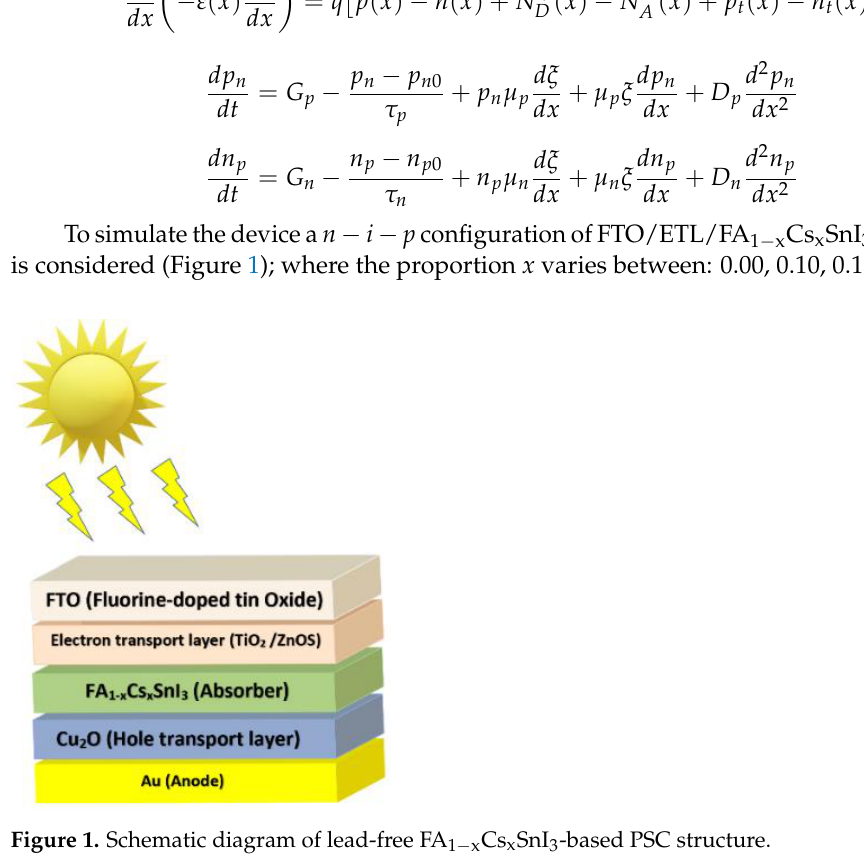
Figure 1. Schematic diagram of lead-free FA 1−x Cs x SnI 3 -based PSC structure.